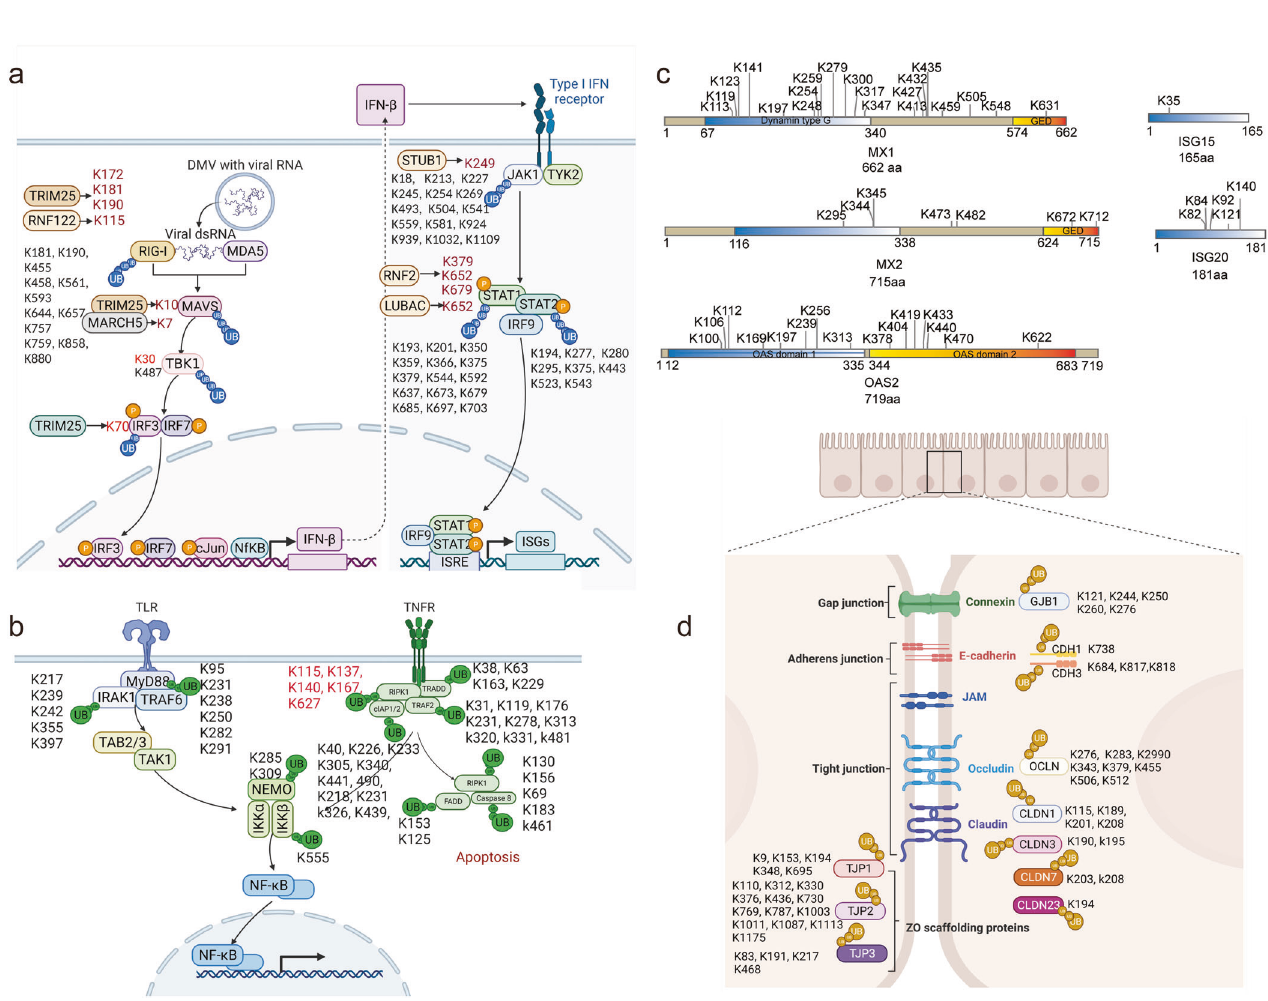
Fig. 2 Ubiquitinomic pro fi ling reveals the pathogenic signaling pathways activated by SARS-CoV-2. The Figures were generated from online tools BioRender. a Proteins with altered ubiquitination after SARS-CoV-2 infection were enriched in RIG-I-MAVS and JAK-STAT signaling pathway. Sites marked in red were reported, and the corresponding E3 ligases were also marked nearby. b The ubiquitination sites on the proteins in TLR and TNF signaling pathway were identi fi ed by MS during SARS-CoV-2 infection. The fi ve sites on RIPK1 marked in red have also been identi fi ed by mass spectrometry in other study. c The diagram shows the ubiquitination sites on multiple ISGs during SARS-CoV-2 infection. d The ubiquitination sites on the proteins in tight junctions signaling pathway were identi fi ed by MS during SARS-CoV-2 infection In addition, SARS-CoV-2 infection also affected the ubiquitina- SARS-CoV-2 infection and in fl ammatory cytokine production. 17 We tion of proteins involved in other physiological activities, like tight provided novel targets for COVID-19 therapies by determining junctions. The ubiquitination of several tight junction molecules, how the SARS-CoV-2 infection activated these in fl ammatory such as Connexin, E-cadherin, Occludin and Claudin, has been signaling pathways. Signal Transduction and Targeted Therapy (2022)